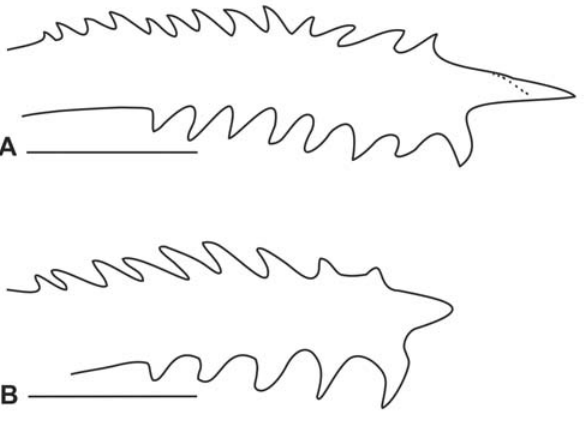
Fig. 3. Dorsal view of left pectoral-fin spine of (a) holotype (INPA 41133, 36.5 mm SL) and (b) paratype (MZUEL 5925, 20.5 mm SL) of Microglanis maculatus , from ribeirão Pouso Alegre, tributary of rio dos Patos, upper rio Tocantins basin, Barro Alto, Goiás State, Brazil. Scale bar = 1